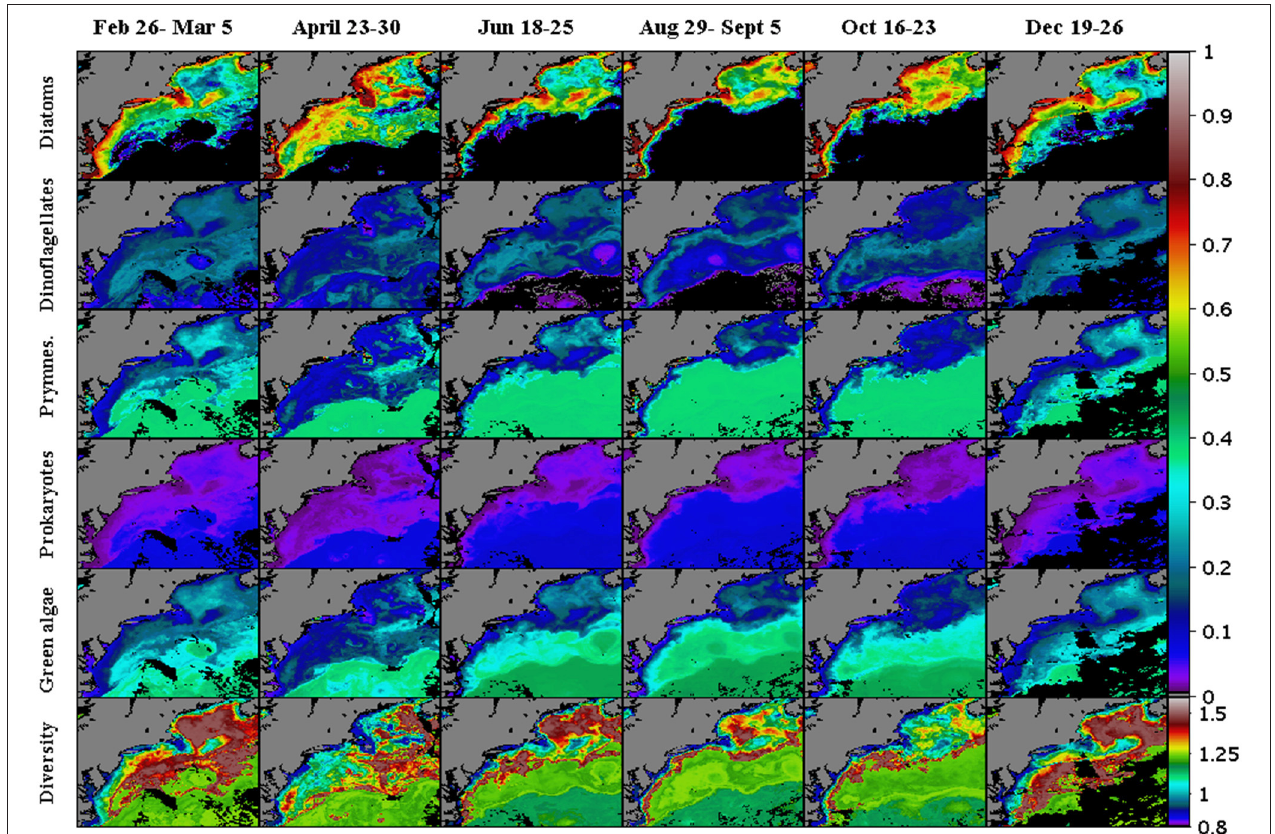
FIGURE 9 | Modeled weekly-mean phytoplankton functional types and calculated Shannon Diversity Index during 2007. Starting from the upper row of images are distribution maps of Diatoms, Dinoflagellates, Prymnesiophytes, Prokaryotes, and Green Algae (% chlorophyll a). Weekly maps of the Shannon Index (H; n.d.) for the PFT diversity are shown along the lower row of panels. Regions where the inverse model yielded zero concentrations are shown in